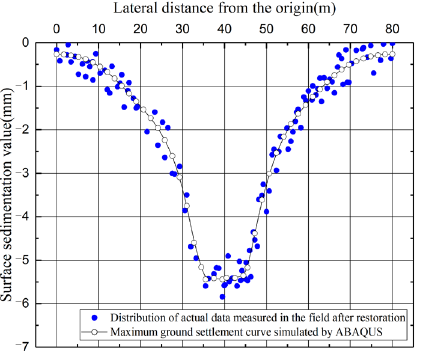
Figure 9. Measured data distribution and numerical simulation settlement curve.